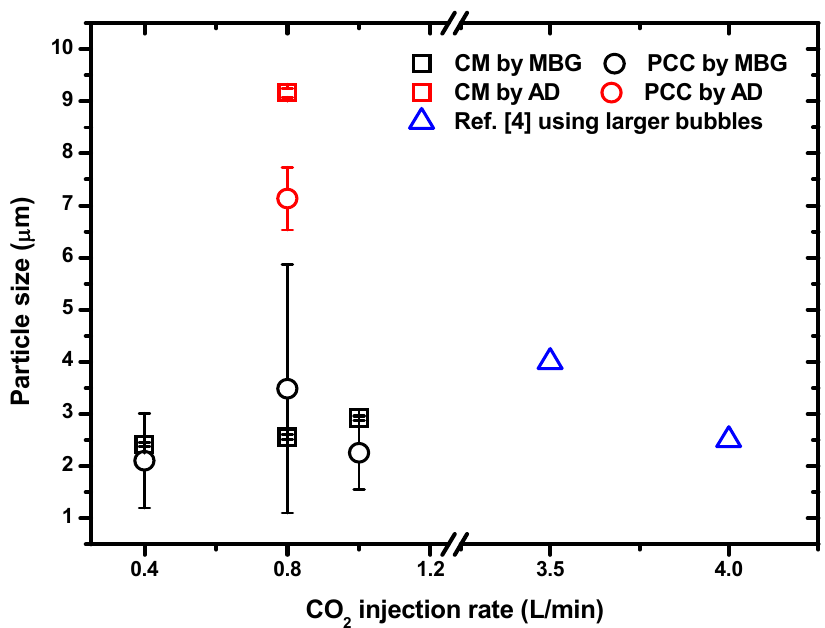
Figure 2. Particle size (PS) of CaCO 3 produced by carbonate mineralization (CM) and precipitated calcium carbonate (PCC) from gypsum (squares □ ) and Ca(OH) 2 (circles ○ ). The effect of CO 2 injection methods (microbubble generator (MBG) and air diffuser (AD)) on the PS were marked additionally in black and red, respectively. The horizontal axis indicates the CO 2 injection rate into the calcium-source suspensions. The PS results using Ca(OH) 2 are from our previous paper [11]. The values in blue triangles are from reference [4] when 101–160 µm bubbles were used, and these are approximate values. The standard deviation was obtained from the repeated experimental results at least